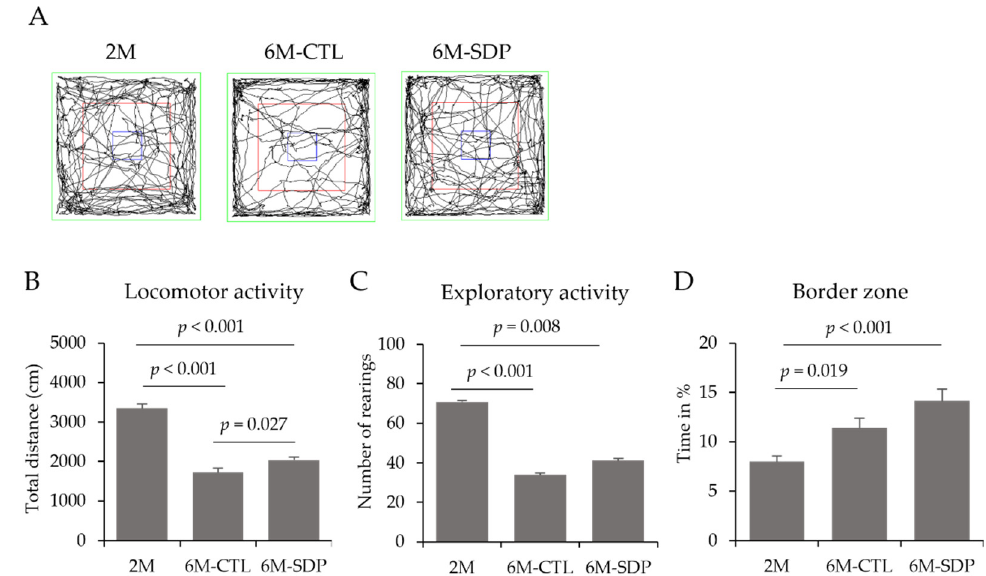
Figure 2. Open field test (OFT). Representative tracking maps of 2M, 6M-CTL, and 6M-SDP groups ( A ), locomotor activity ( B ), exploratory activity ( C ) and percentage of time in the border zone ( D ). Results are expressed as mean ± SEM ( n = 11–12 mice/group). Statistics: ANOVA (Fisher multiple comparison test), and Kruskal–Wallis test.